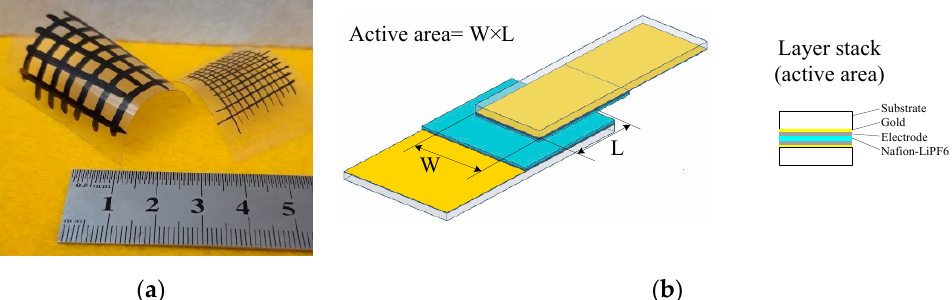
Figure 1. ( a ) Conducting patterns on transparency sheets that were handwritten using pens filled with the PPy:DBSA ink (the sample with thicker lines, viscosity 2.58 mPa ⋅ s) and the PPy-GNP:DBSA ink (the sample with thinner lines, viscosity 4.11 mPa ⋅ s); ( b ) schematic view of the supercapacitor structure. The substrate (Substrate) was cut out from a copier grade transparency sheet on top of which a gold layer (Gold) was thermally evaporated. Electrodes (Electrode) were applied using rechargeable pens filled with inks prepared as described in the above section. A nafion membrane impregnated with lithium hexafluorophospate was used as a separator